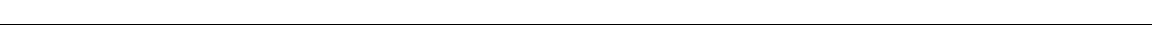
Figure 4 | Integrative analysis of HGSOC tissue and cell line proteomes. ( a ) Proteomic clustering of eight HGSOC tissue specimens. PCA was performed on the ovarian tumour specimens ( n ¼ 8) based on the proteomic profiles to evaluate inter-patient heterogeneity and intra-patient homogeneity. Component 1 and component 2 account for 51.5% of the total data variation. ( b ) PCA clustering of cell lines ( n ¼ 30), FTEC ( n ¼ 3) and HGSOC tissue proteomes ( n ¼ 8). Groups I (green), II (blue) and III (red) are as defined in Fig. 3. The juxtaposition of the IOSE cell lines, red circles outlined in black, relative to the rest of the group III cell lines is indicated. Component 1 and component 2 account for 28.1% of the total data variation. ( c ) PCA segregation and clustering of all samples based on the 67-protein signature. The juxtaposition of the IOSE cell lines, red circles outlined in black, relative to the rest of the group III cell lines is indicated. Component 1 and component 2 account for 54.8% of the total data variation. The dendrogram below the PCA summarizes the hierarchical clustering analysis of all samples based on the 67-protein signature. Two main clusters were obtained based on this signature (detailed in Supplementary Fig. 3c). ( d ) Relative levels of the 67 proteins used for PCA clustering in c . Relative protein levels (MaxLFQ intensities, log2) are depicted by circle size. Colours indicate protein sequence coverage per sample. MSLN is depicted twice, representative of two different isoforms (shown in parentheses). ( e ) Immunofluorescence staining for CRABP2 and p53 in formalin-fixed paraffin-embedded (FFPE) sections of normal OSE and ovary HGSOC tumour. FFPE sections were stained with an anti-CRABP2 antibody and an anti-p53 antibody, and detected with Alexa Fluor 488- and Alexa Fluor 647-labelled antibodies, respectively. Merged images on the bottom show invasive HGSOC, normal OSE and normal ovarian stroma in the same frame. Scale bar, 50 m